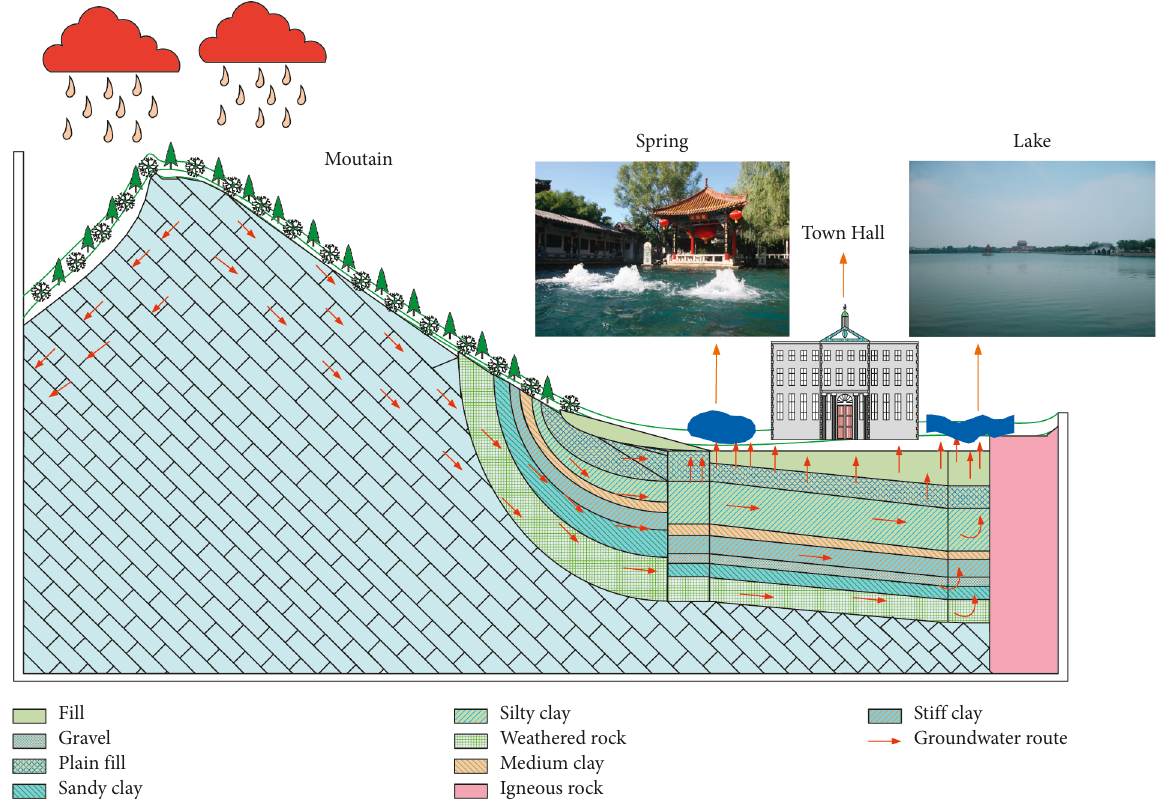
Figure 2: Geology and origination of